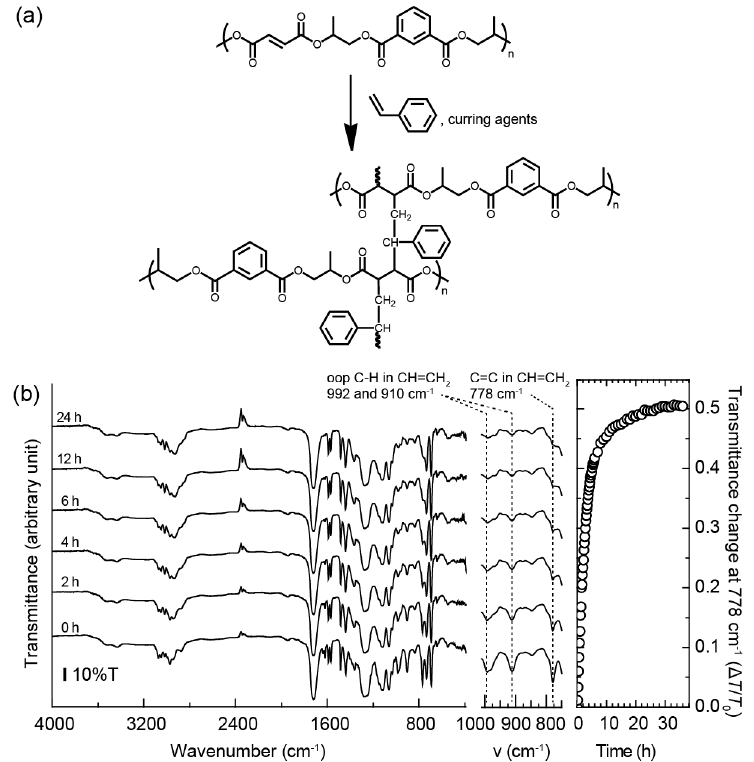
Figure 4. ( a ) Crosslinking reaction of the UP resin. ( b ) ATR-FT/IR spectra of a UP resin film and the transmittance change Δ T / T 0 at 778 cm − 1 . transmittance change ∆ T / T 0 at 778 cm − 1